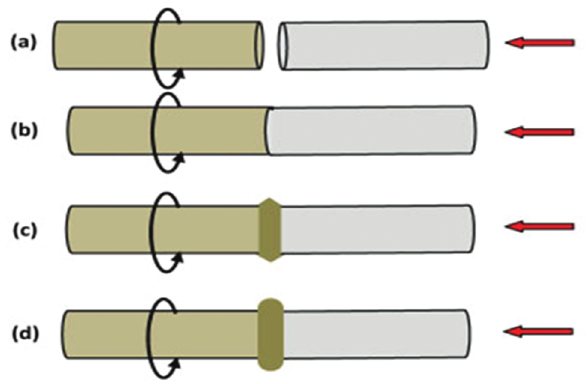
Figure 1: Basic steps in friction welding.